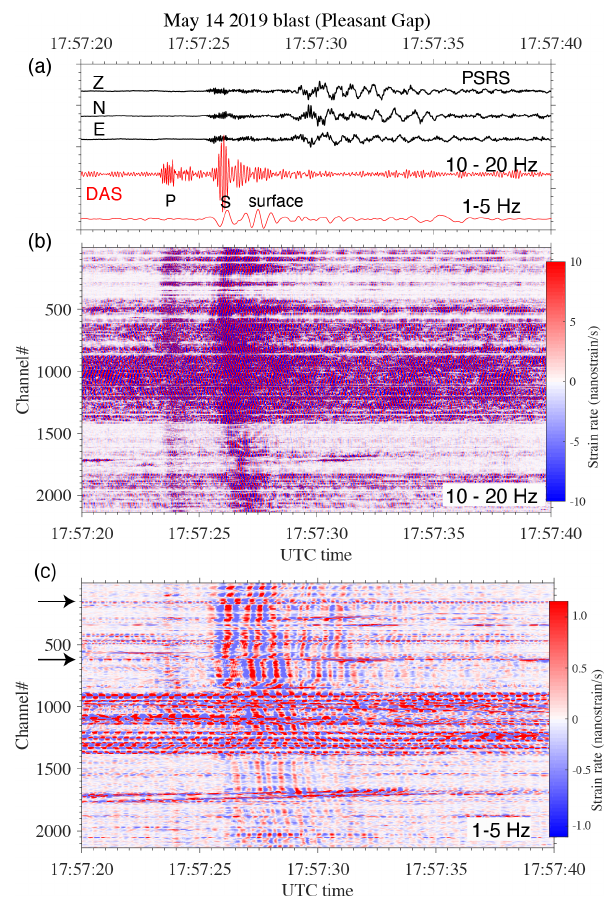
Figure 14. Seismic station (PSRS) and DAS recordings of one blast (M1.0) from site 4 (see Fig. 12), about 10km away from State College. (a) Three-component seismogram (band-pass filtering, 1– 15Hz) and 100th DAS trace with filtering by two different band- pass filters. DAS recording after (b) band-pass filtering (10–20Hz) and (c) band-pass filtering